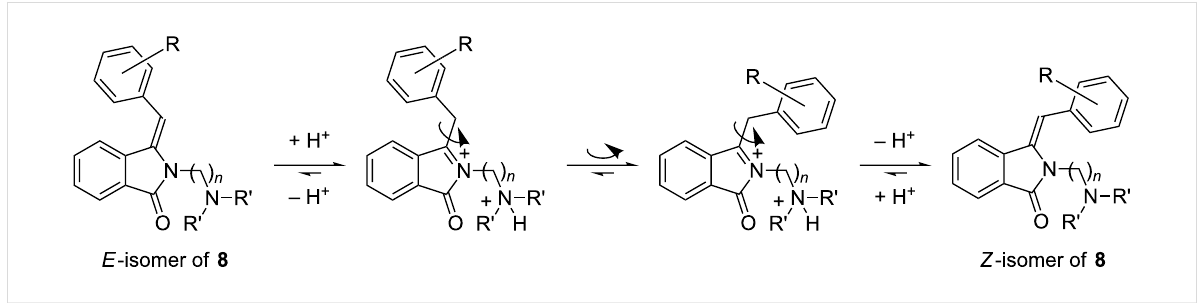
Scheme 8: Possible scenarios for nucleophilic cyclization to 4 .